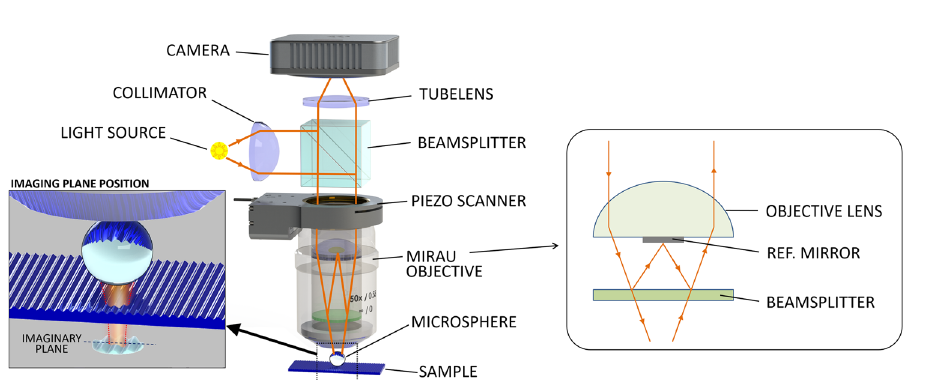
Figure 3. Microsphere-assisted imaging: setup with a Mirau type interferometer and a microsphere placed on top of an object. The sphere projects a virtual image into the far-field that is collected by the objective lens. Zoom-in is not to scale. The insert on the right shows the design and the ray propagation in a single objective Mirau type